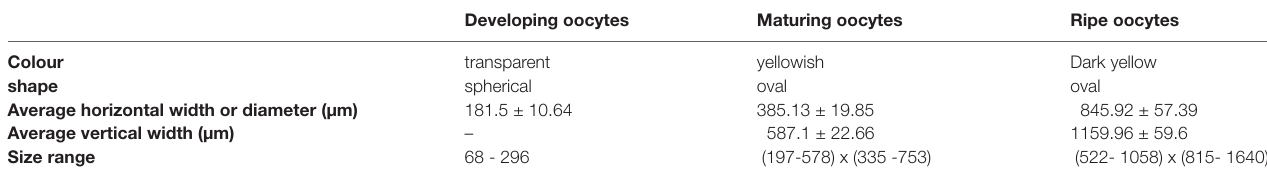
TABLE 5 | Maturation stages of oocytes observed in female P. maculatus based on oocyte dimensions and colour.